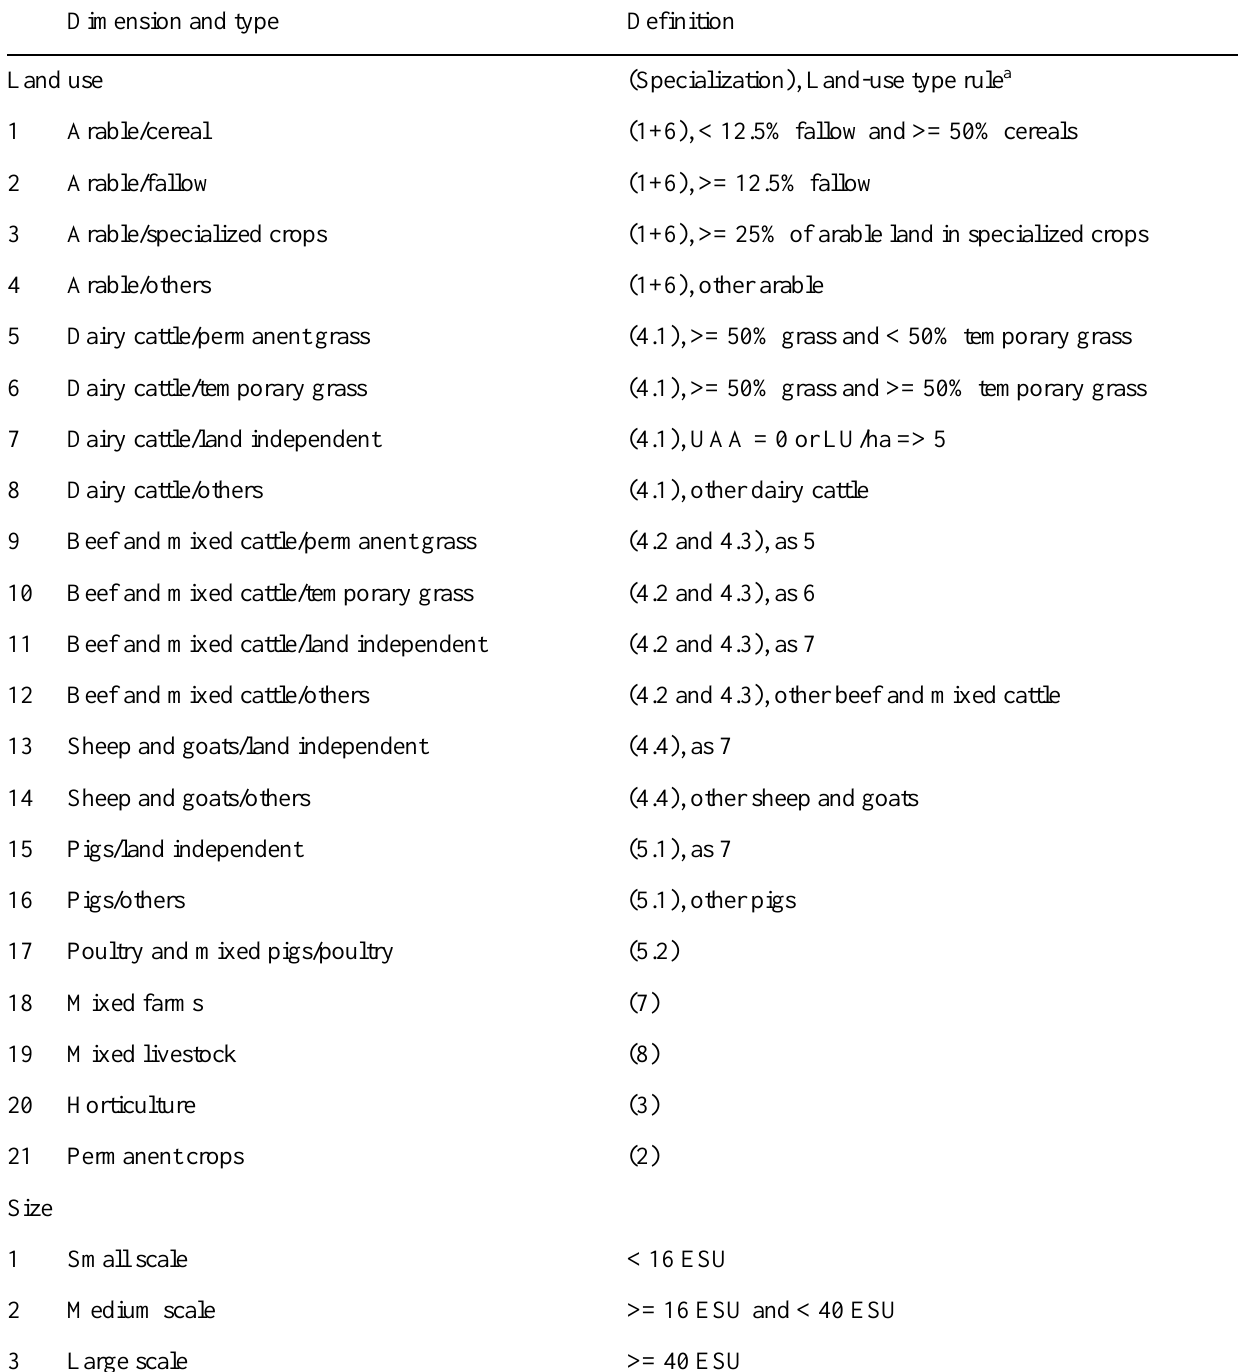
Table 1. Farm typology. Each farm type is characterized by a land use, size, and intensity dimension. Dimension and